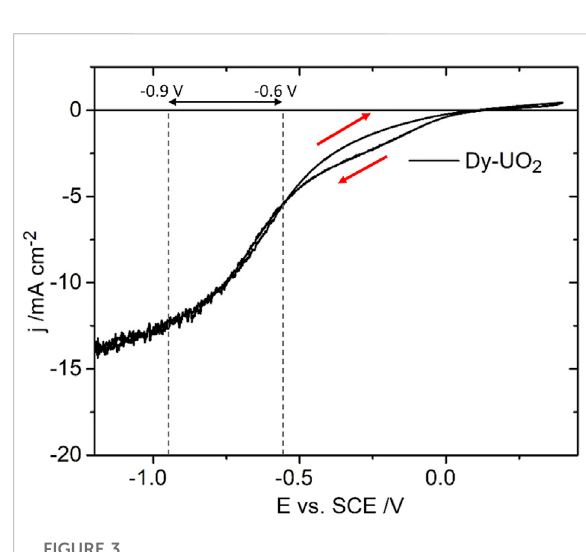
FIGURE 3 The current density (j) as a function of applied potential (E) recorded in a CV on Dy-UO 2 in a 0.1 mol.L − 1 NaCl solution containing 0.02 mol.L − 1 of H 2 O 2 , and 0.05 mol.L − 1 of NaHCO 3 (pH = 9.7), electrode rotation rate ( ω ) = 8.33 Hz, and scan rate = 10 mV s − 1 . The red arrows indicate the scan direction; the dashed lines and horizontal arrow show the region − 0.6 V to − 0.9 V, within which oxide fi lms are